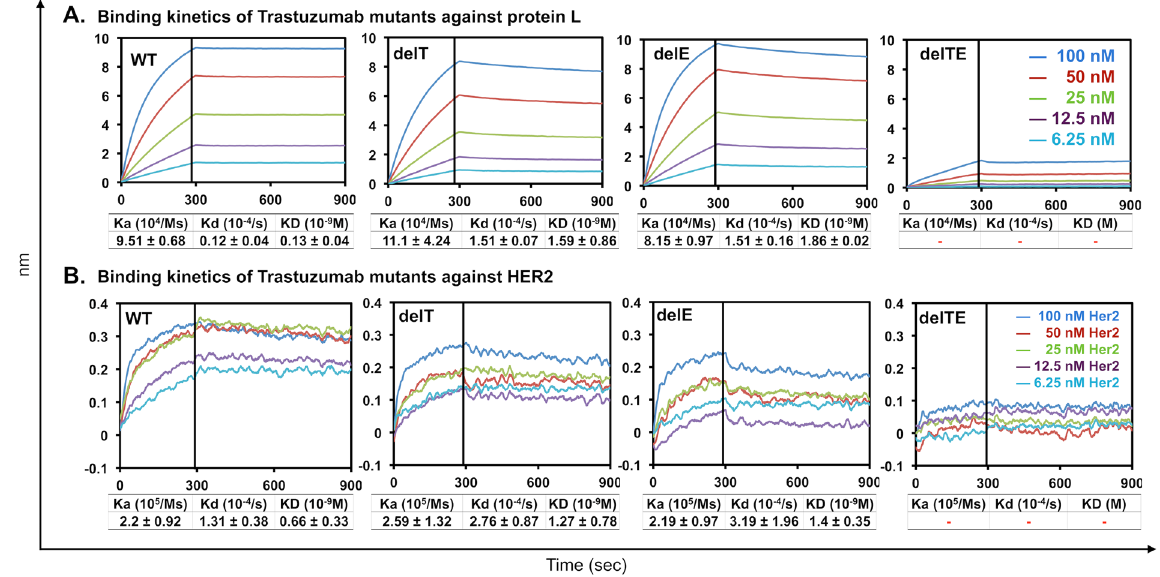
Figure 2. Binding kinetics profiles of Trastuzumab WT and its mutants from three independent experiments with corresponding average association (Ka), dissociation (Kd) and overall binding kinetic (KD) values with standard deviations. ( A) Binding kinetics of decreasing concentration (100 nM to 6.25 nM) of Trastuzumab mutants to protein L biosensor, and ( B ) binding kinetics of Trastuzumab mutants using anti-human Fc capture biosensor to varying concentrations of Her2 (100 nM to 6.25 nM). Poor binding responses of the delTE mutant against protein L and Her2 produced unreliable binding kinetics values as determined by the Octet software for response value <